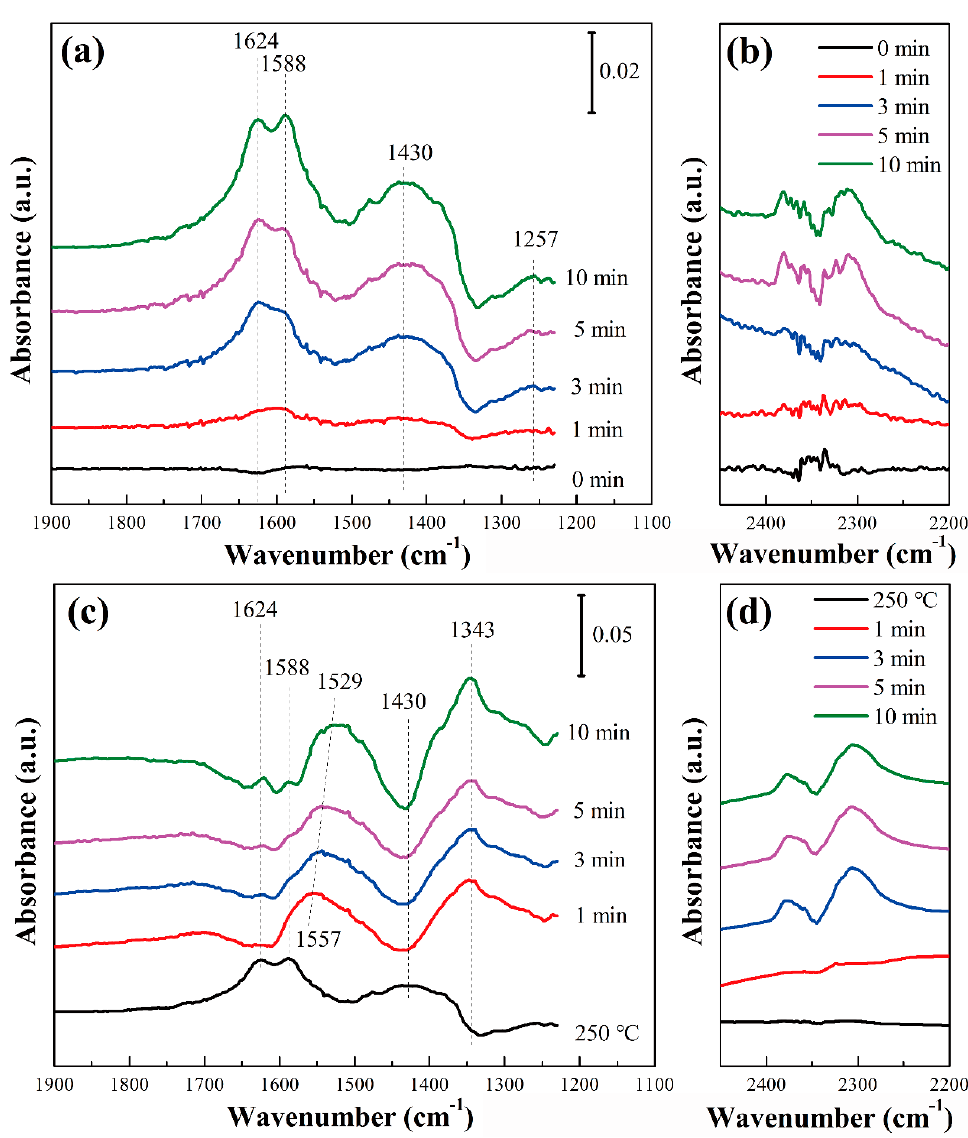
Figure 9. In-situ diffuse reflection infrared spectrum of chlorobenzene adsorption on 10C-CM/T: ( a )